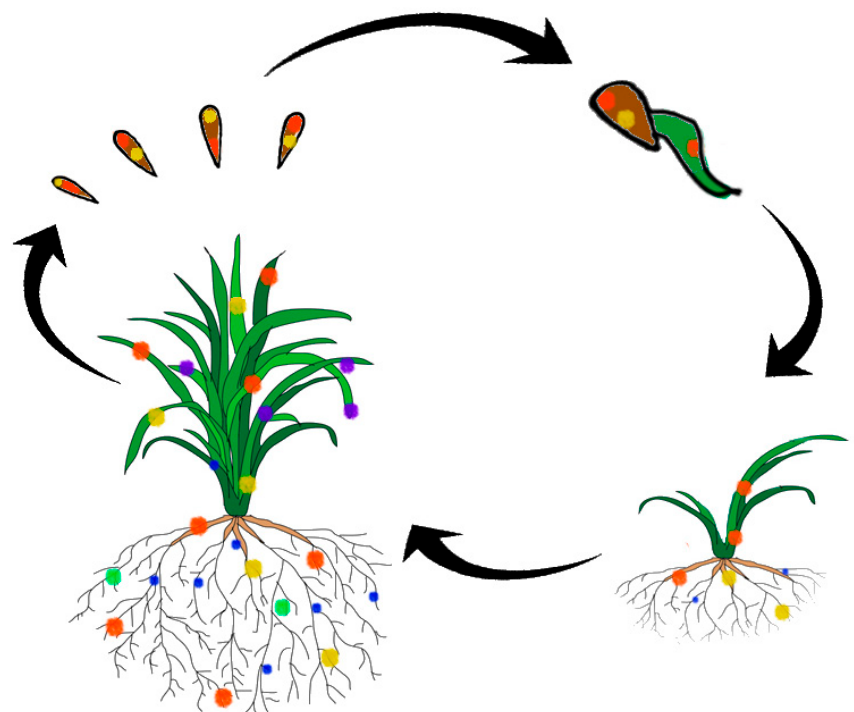
Figure 1. Seeds from the mature plant contain specific microbes which are essential for successful germination. These seed endophytes become the first microbes to inhabit the new plant, as it establishes itself in its environment. Each color represents a phylum of endophytes, and highlights how not all endophytes present in the mature plant become part of the seed.